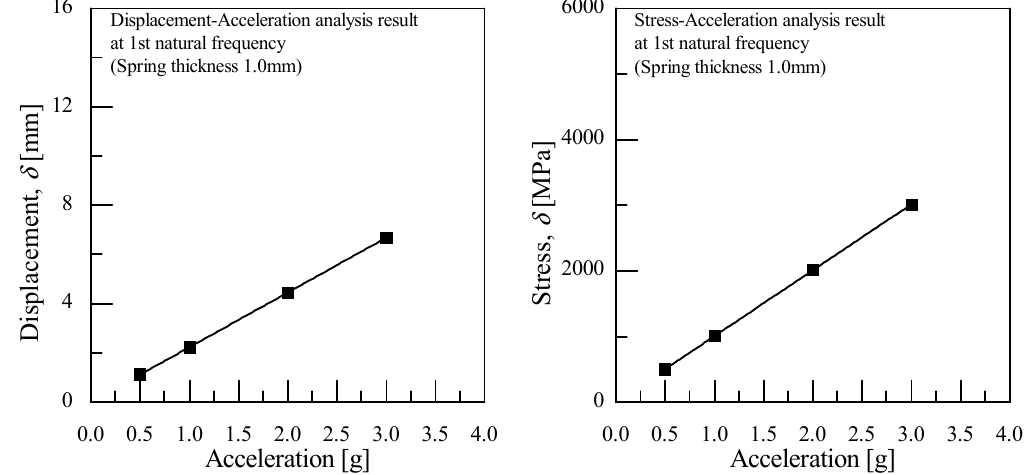
Figure 9. The results of the finite element analysis (FEA) for the displacement and the stress according to the vibration acceleration.